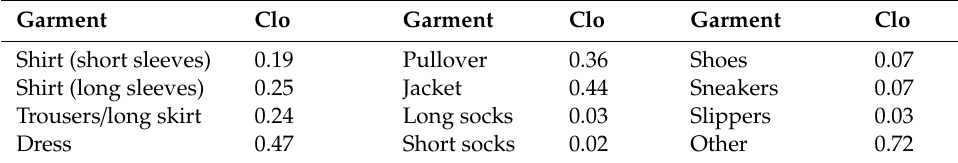
Table A1. List of garments used in the questionnaire and the clo values assigned for winter.